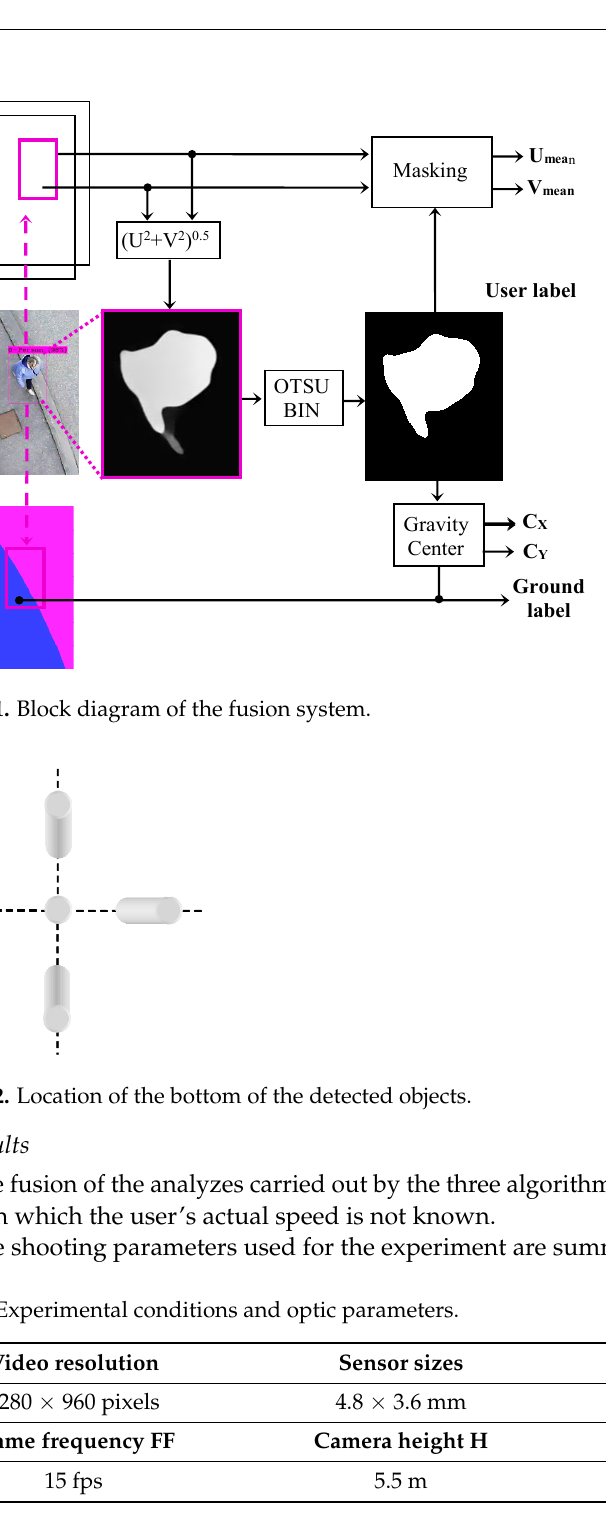
Table 5. Experimental conditions and optic parameters.